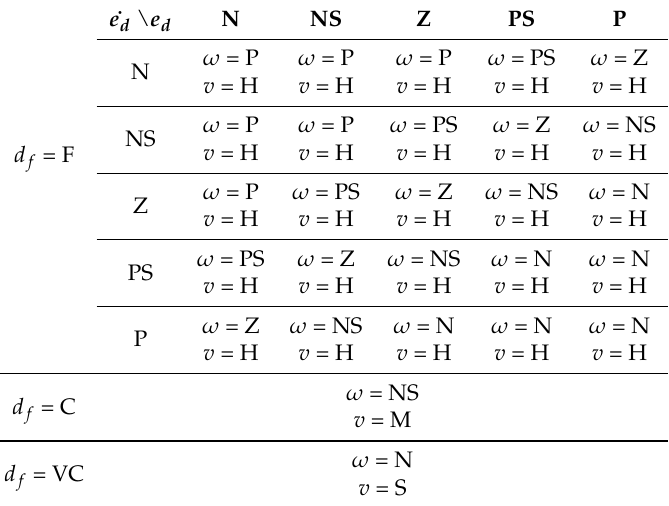
Table 1. Rule base of the